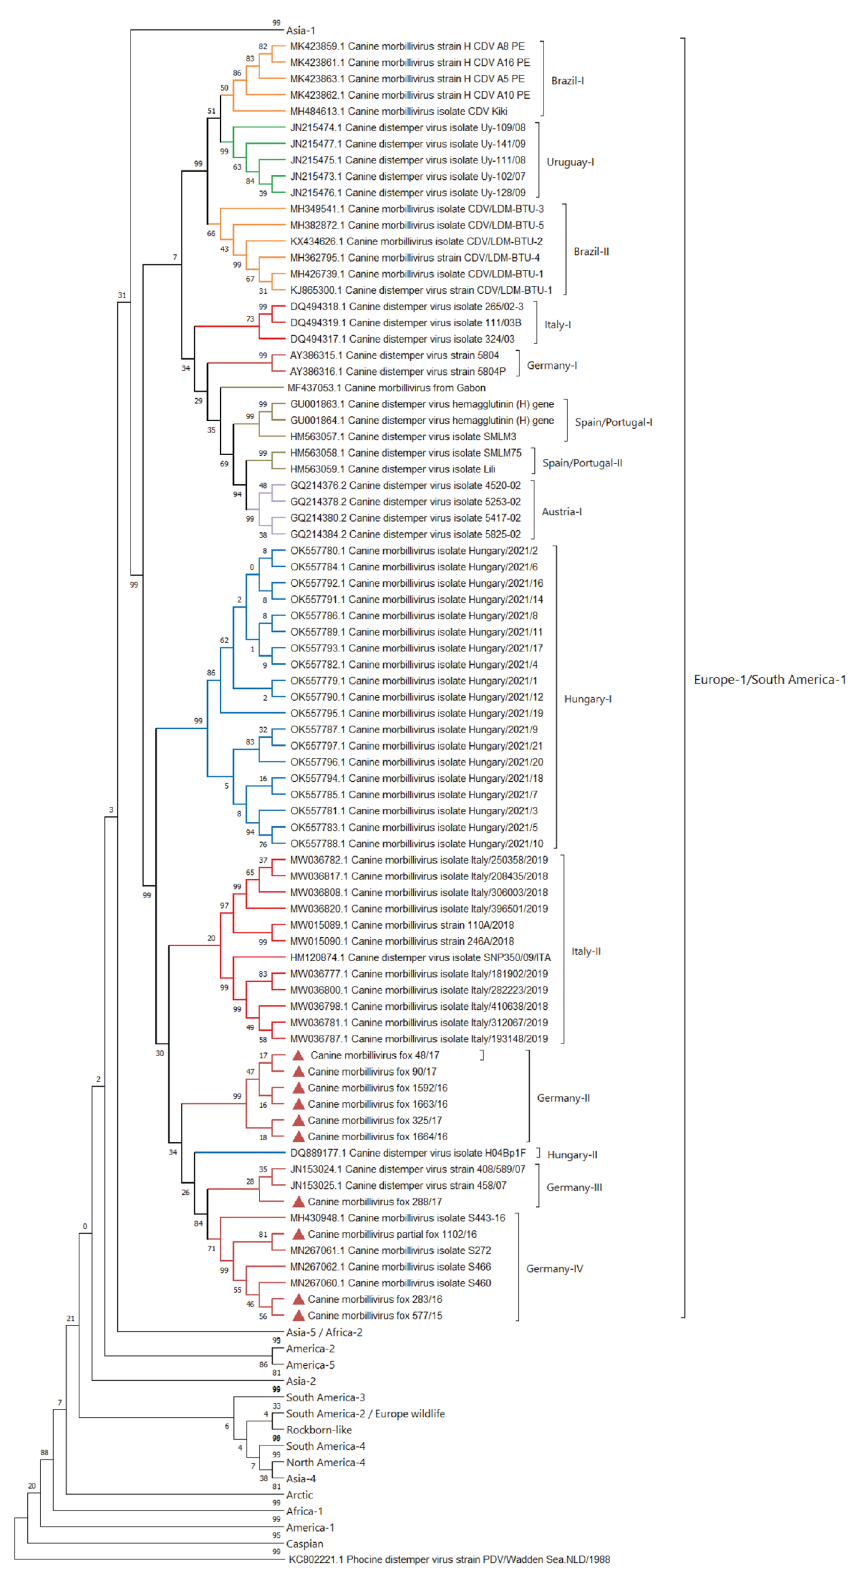
Figure 6. Maximum-likelihood phylogenetic tree of 600 complete CDV-H gene sequences including ten H gene sequences amplified from fox tissue. Bootstrap values are presented at nodes. The H gene sequence of phocine distemper virus (GenBank accession no. NC028249.1) was used as an outgroup. Foxes from this study are indicated by filled triangles (red) at tip ends. Numbers on the nodes indicate bootstrap